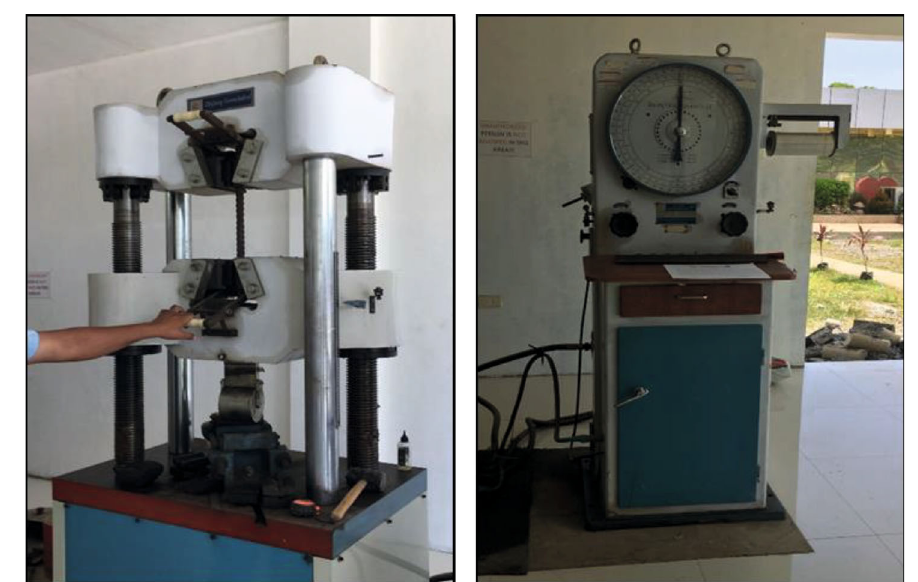
Figure 8: Pull-out testing